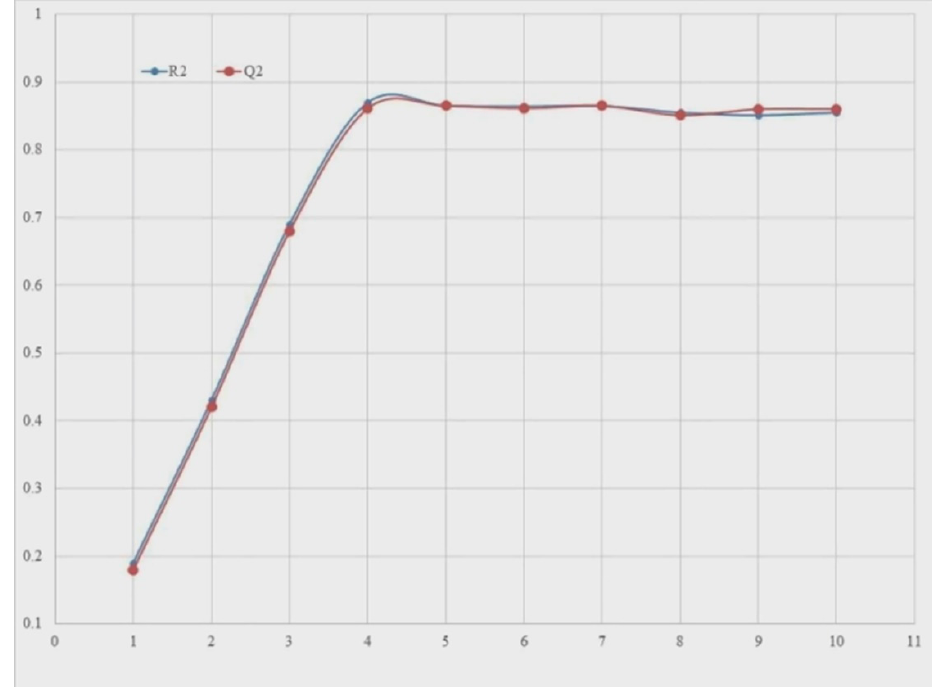
Figure 20. Plot of number of descriptors against Coefficient of Determination R 2 and Leave-One-Out Coefficient of Determination Q 2 to identify the optimum number of descriptors.